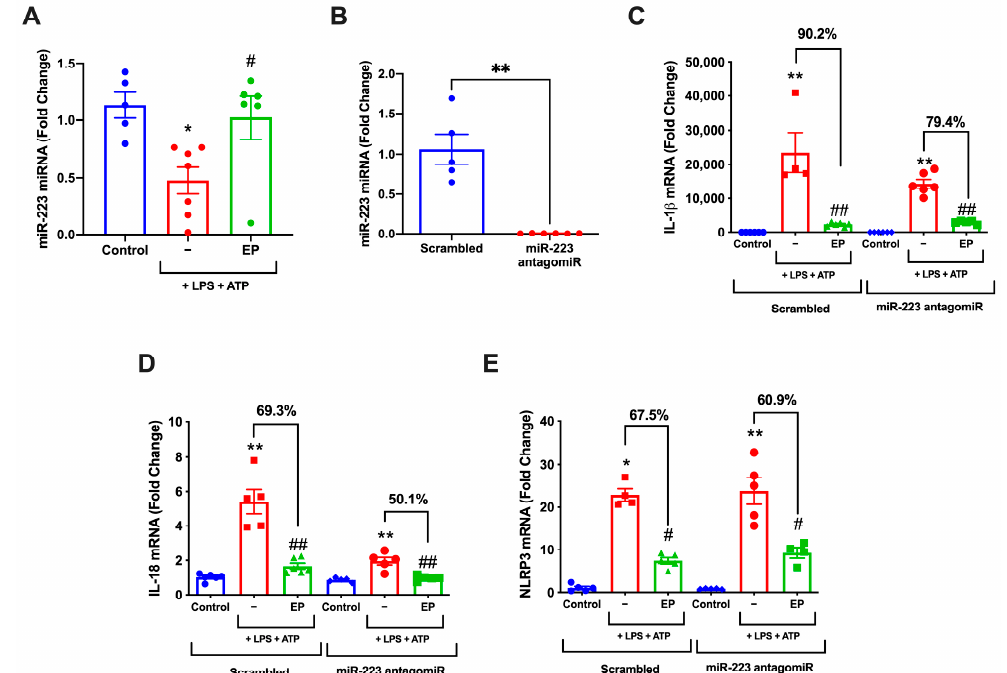
Figure 6. miR-223 inhibition impairs the protective role of EP in inflammasome activation. N9 cells were treated with antagomiR-223 before EP (10 mM) for one hour, then treated with LPS (1 µ g/mL) for four hours, and ATP (5 mM) for 1 h. ( A ) miR-223 expression without any modification decreased in LPS- and ATP-treated group and increased in the EP pre-treatment group. ( B ) miR-223 levels were suppressed following miR-223 antagomiR transfection. ( C ) After mir-223 inhibition, the difference in NLRP3 between the LPS and ATP and EP pre-treatment groups decreased. ( D ) After mir-223 inhibition, the difference in IL-1 β between the LPS and ATP group and EP pre-treatment group was decreased. ( E ) After mir-223 inhibition, the difference in IL-18 between the LPS and ATP group and the EP pre-treatment group was decreased. Data are presented as mean ± S.E.M, n = 5. * p < 0.05 and ** p < 0.01 compared to control and # p < 0.05 and ## p < 0.01 compared to LPS-induced cells.